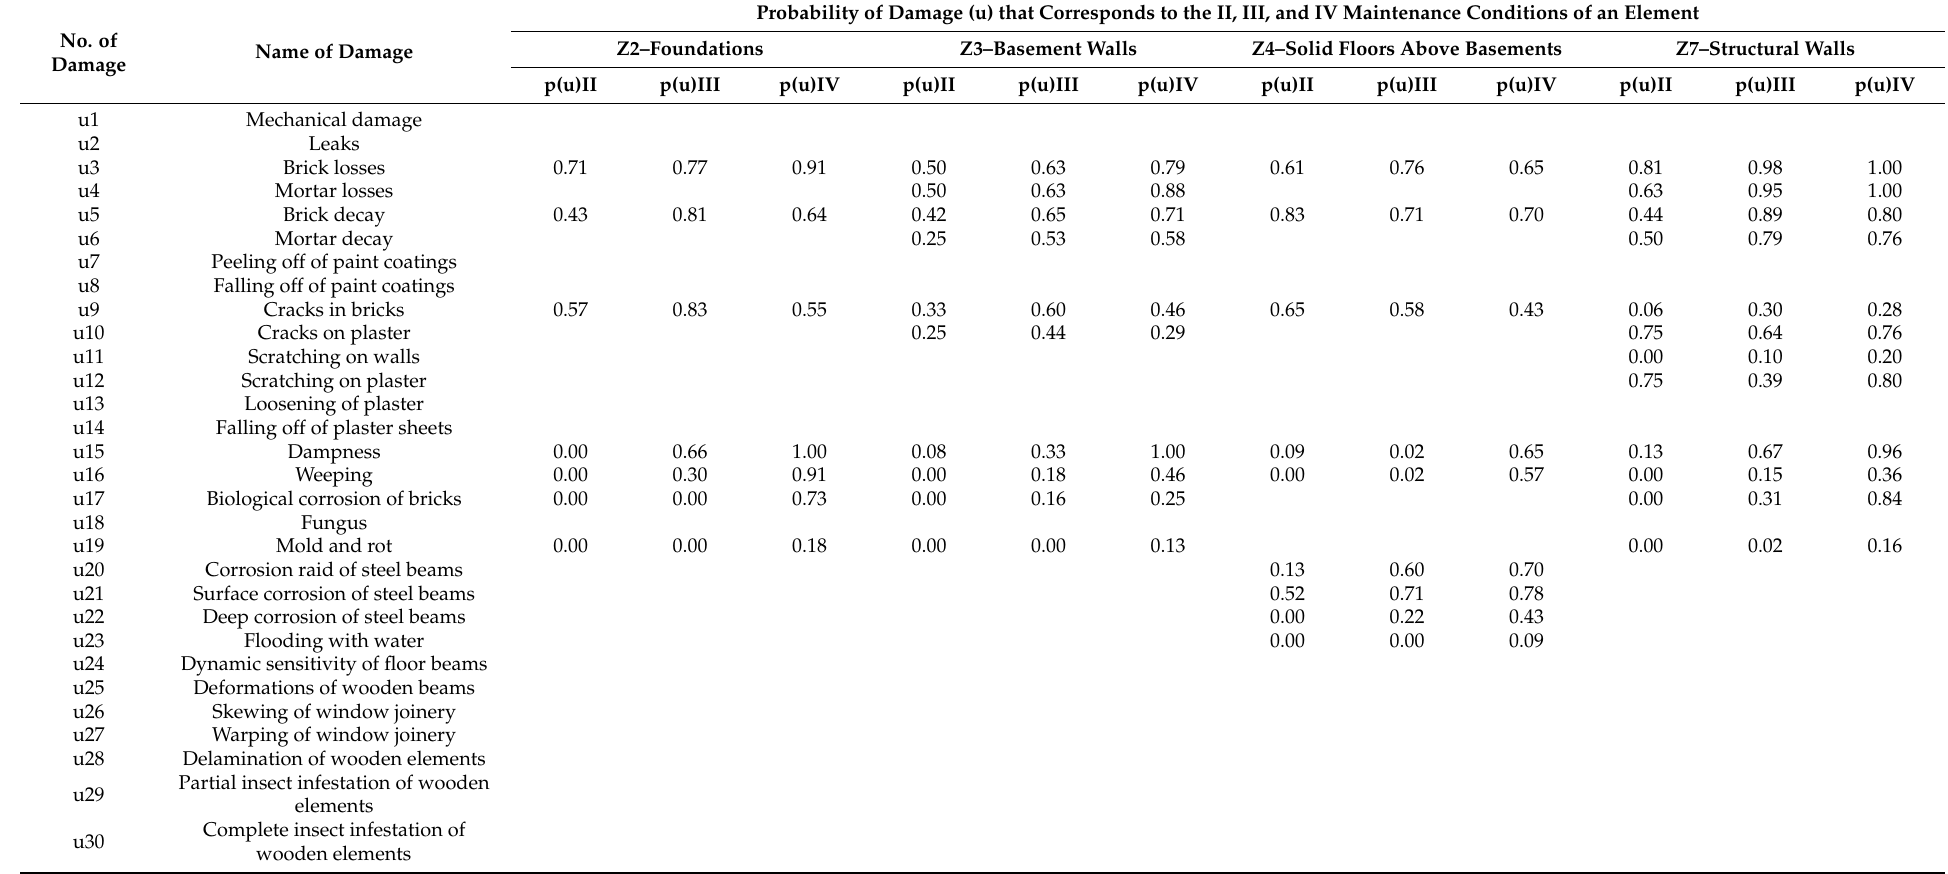
Table 1. Probability p(u i ) of elementary damage u i for 10 selected building